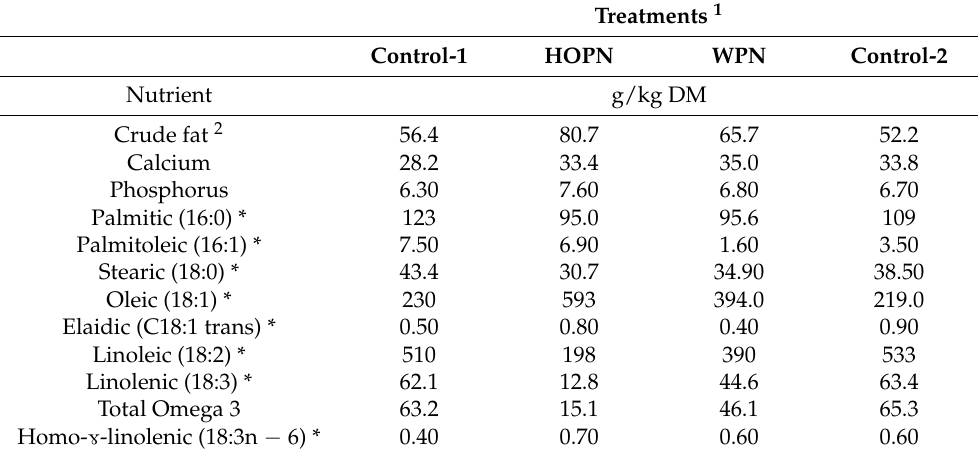
Table 2. Chemical and fatty acid analysis of experimental laying hen control and peanut-containing